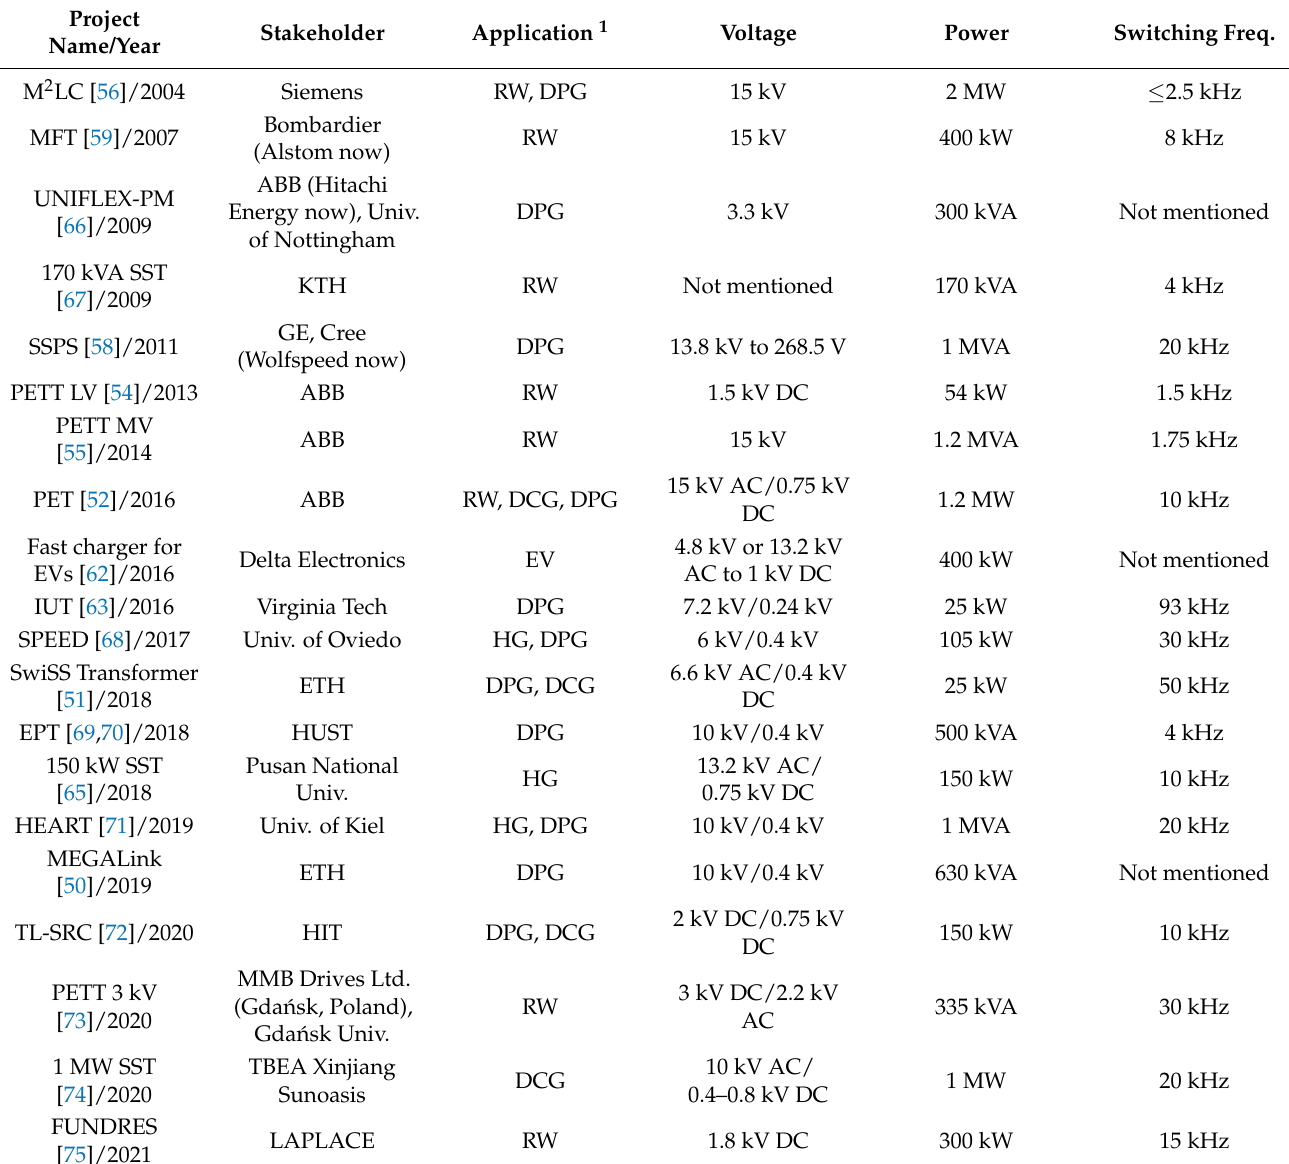
Table 1. Projects related to SST